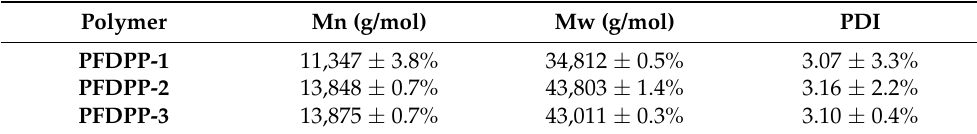
Table 3. Distribution of molecular weights determined by